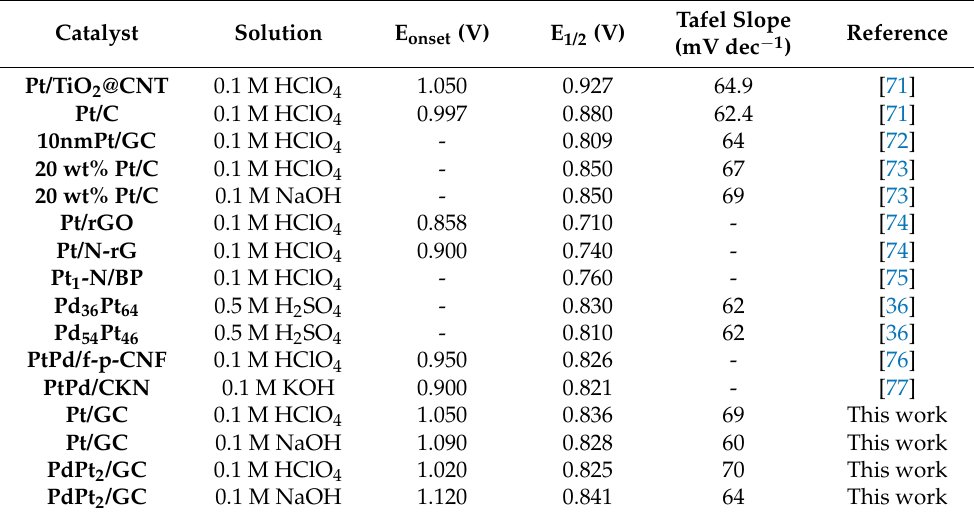
Table 4. Comparison of the catalytic activity for ORR on various Pt and PdPt nanoparticles supported by carbon-based